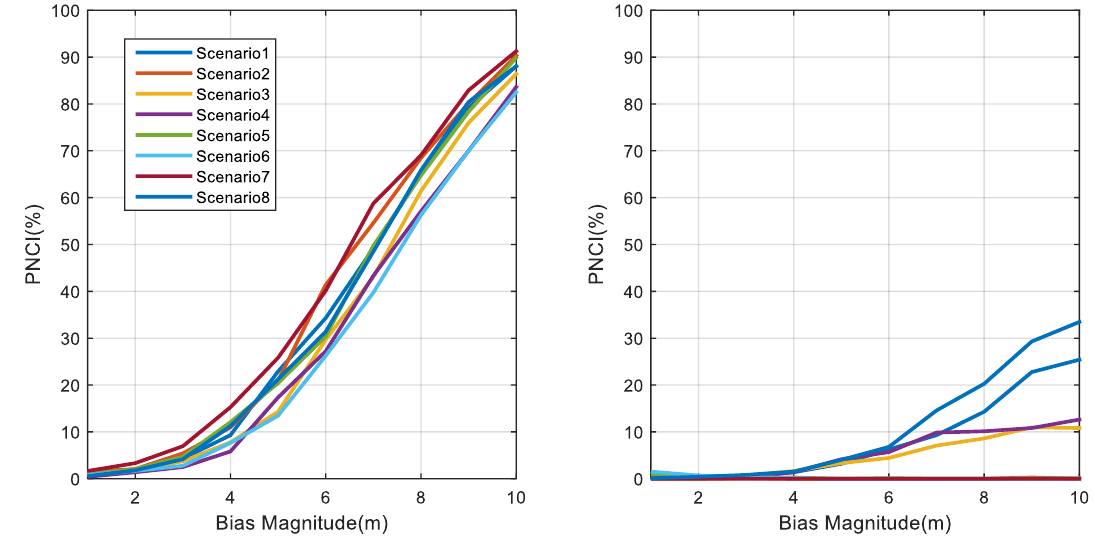
Figure 12. Compare of PNCI with different NLOS bias and anchor geometry scenarios for the MC algorithm ( Left ) and the ML method ( Right ).